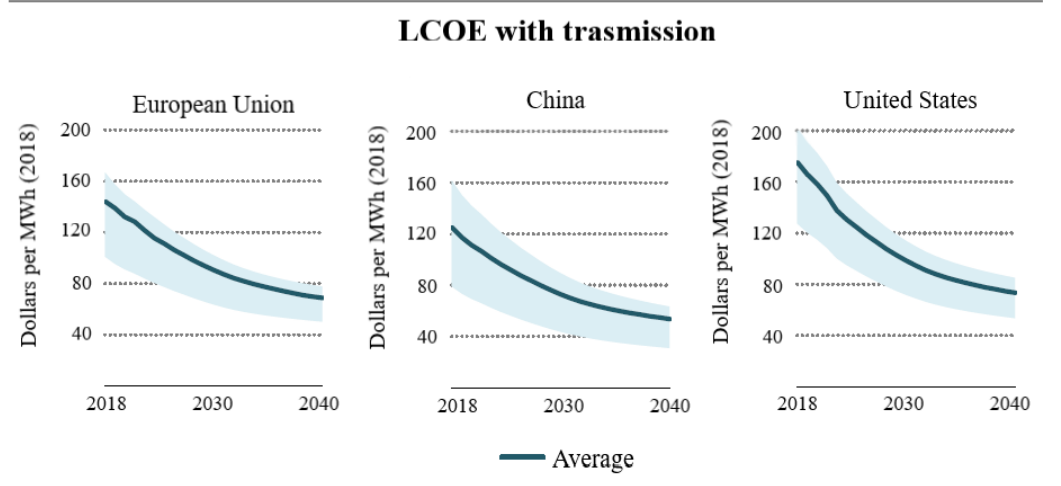
Figure 2. Levelized Cost Of Energy (LCOE) for new offshore wind projects in the European Union, China, and United States from 2018 to 2040, adapted from the work in